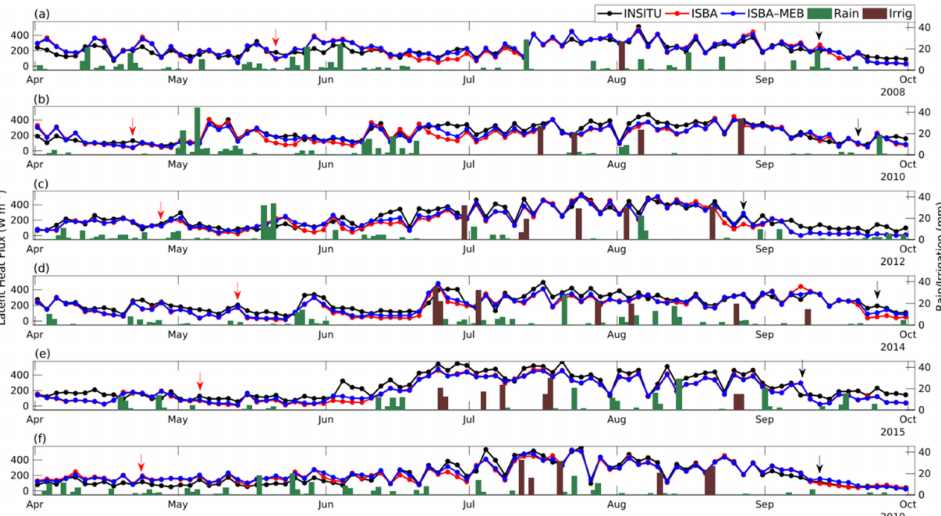
Figure 5. The 2-days average daytime series of the in situ latent heat flux (LE) (in black) with those estimated by ISBA (in red) and ISBA-MEB (in blue). Panels ( a – f ) represent the plots for 2008, 2010, 2012, 2014, 2015, and 2019, respectively. The red and black arrows signify the planting and the harvest days,